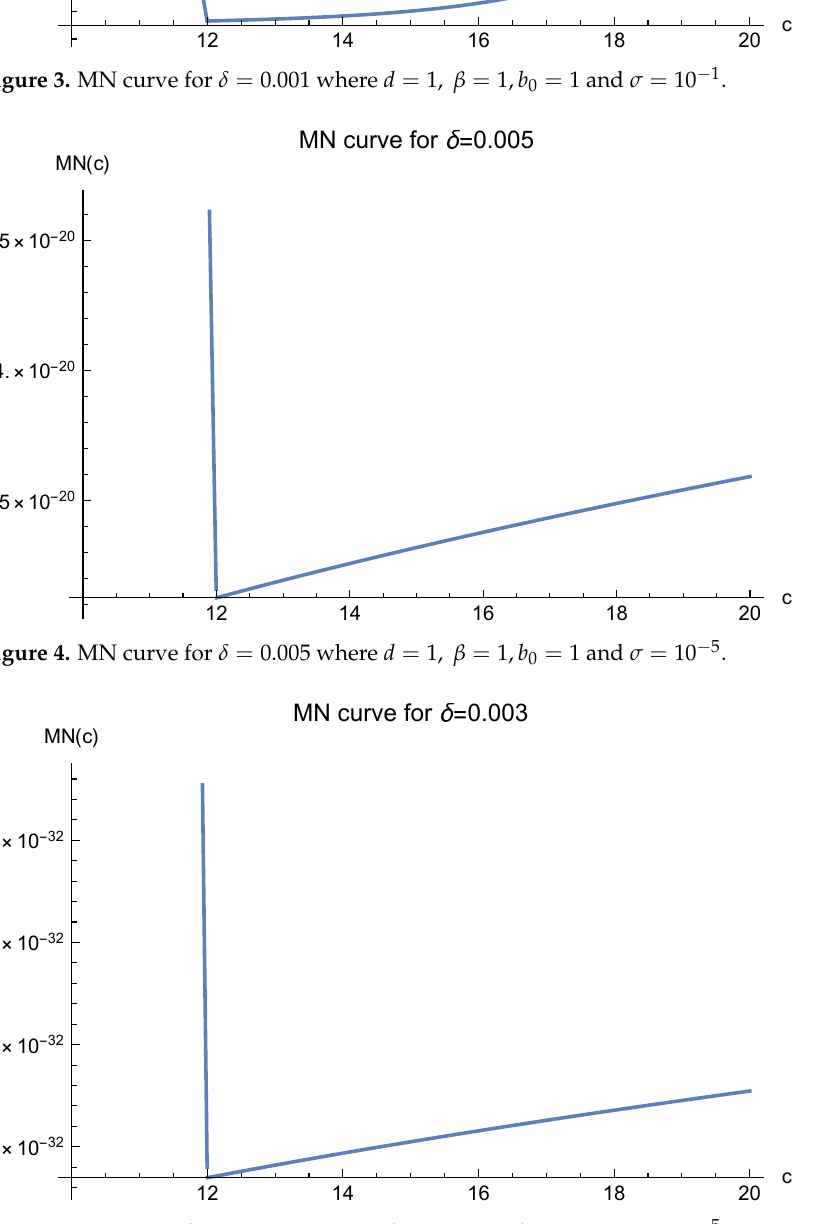
Figure 5. MN curve for δ = 0.003 where d = 1, β = 1, b 0 = 1 and σ = 10 − 5